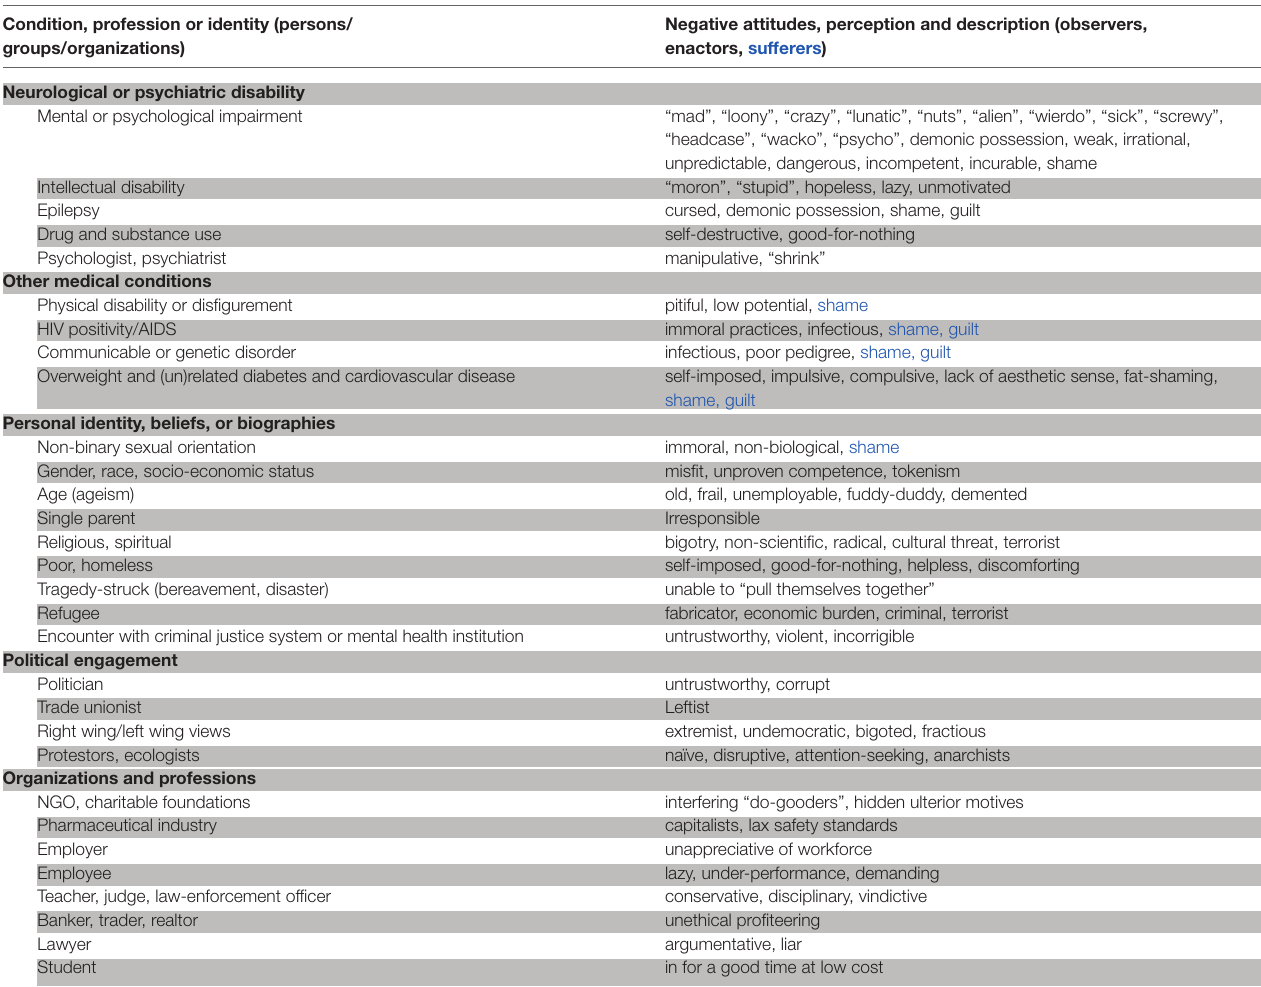
TABLE 1 | Characteristics of a person, group or organization that may kindle or trigger stigmatizing attitudes, reactions, and practices by those they encounter. Condition, profession or identity (persons/